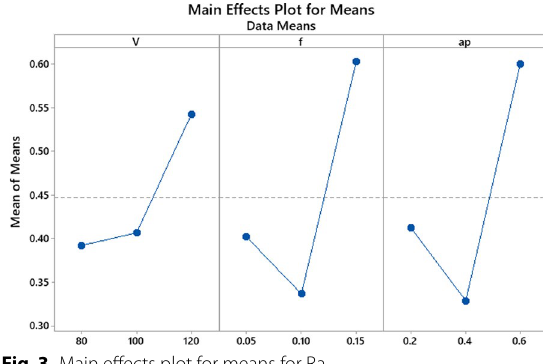
Fig. 3 Main effects plot for means for Ra